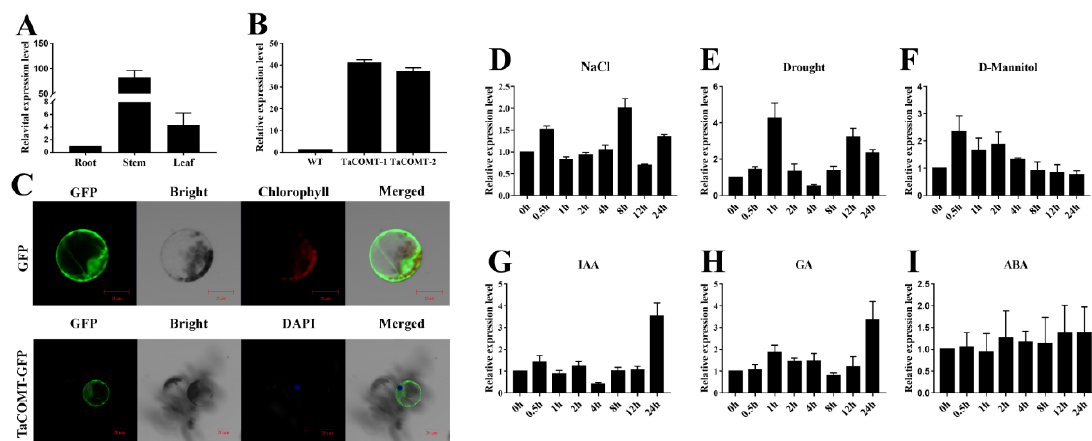
Figure 2. Tissue expression specificity, expression patterns under group stresses and phytohormones and subcellular localization of TaCOMT. Analysis of transcriptional level of TaCOMT in roots, stems, and leaves by qRT-PCR ( A ). Expression of TaActin as a loading control. Expression analysis of transgenic lines by qRT-PCR ( B ). Expression of AtActin as a loading Control. Expression patterns of TaCOMT after treatment with NaCl ( D ), Drought ( E ), D-Mannitol ( F ), 3-Indoleacetic acid (IAA) ( G ), gibberellin (GA) ( H ), and ABA ( I ) for 0, 0.5, 1, 2, 4, 8, 12 and 24 h. Analysis of transcriptional level by qRT-PCR assay. Expression of TaActin as a loading control. The data are shown as the means ± SDs of three experiments. Transient expression of 35S::TaCOMT-GTP with DAPI staining and GFP control vectors in wheat protoplasts ( C ). Scale bars = 20 µ